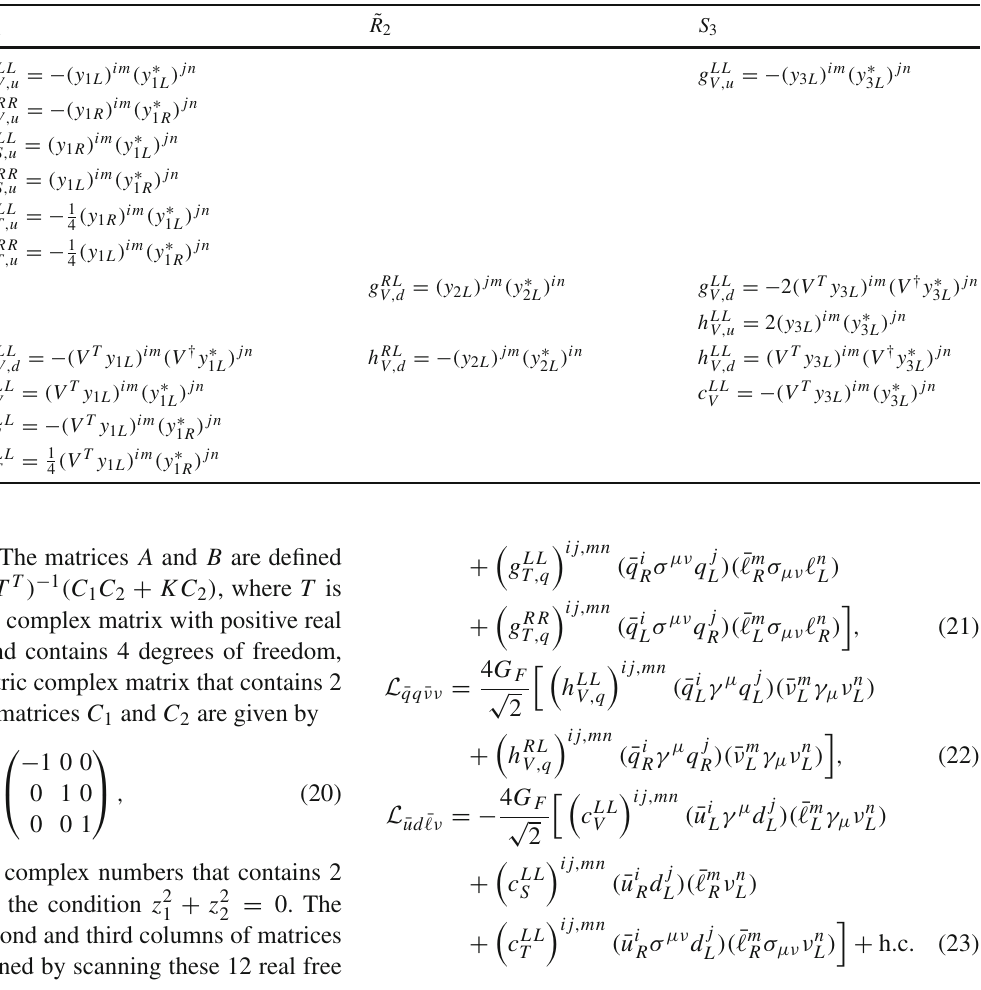
Table 1 The corresponding Wilson coefficients (in units of v 2 / 4 m 2 scale is set at the leptoquark mass